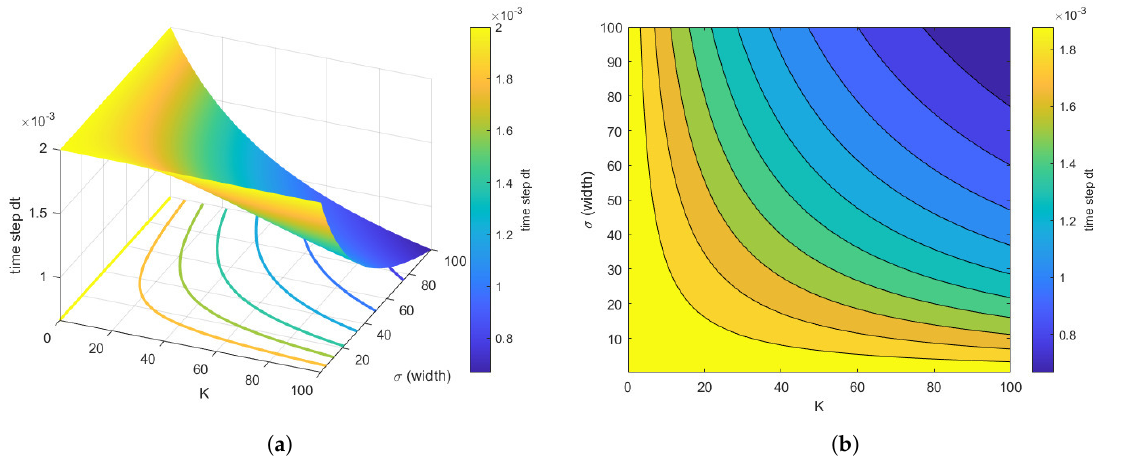
Figure 3. Time step restriction (64) different K and channel widths ( b one-dimensional hyperbolic Equation (62) with f =